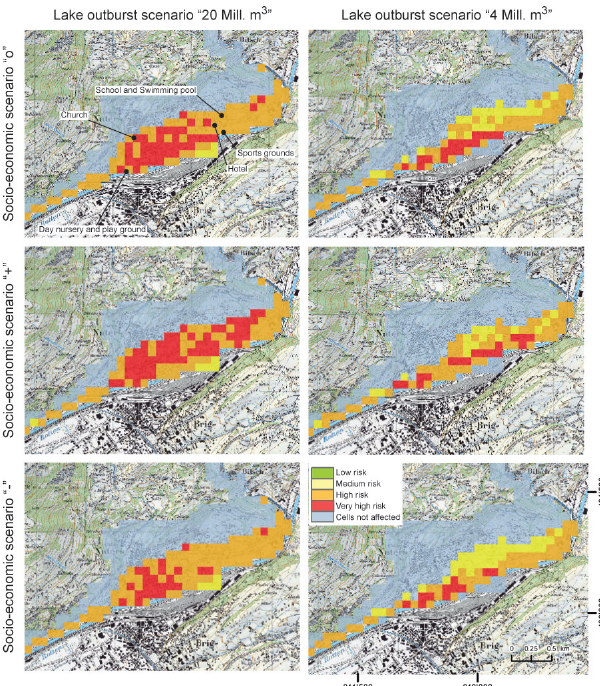
Figure 8. Risk for Naters in 2045 for lake outbursts considering the risk matrix (b) in Fig. 4. The three rows indicate the socio-economic scenarios “o”, “ + ”, and “ − ”, the two columns the lake outburst sce- narios with 20 and 4millionm 3 . Arrows indicate hotspot locations of social vulnerability. Reproduced with permission of Swisstopo (BA110005) and BFS (1986,